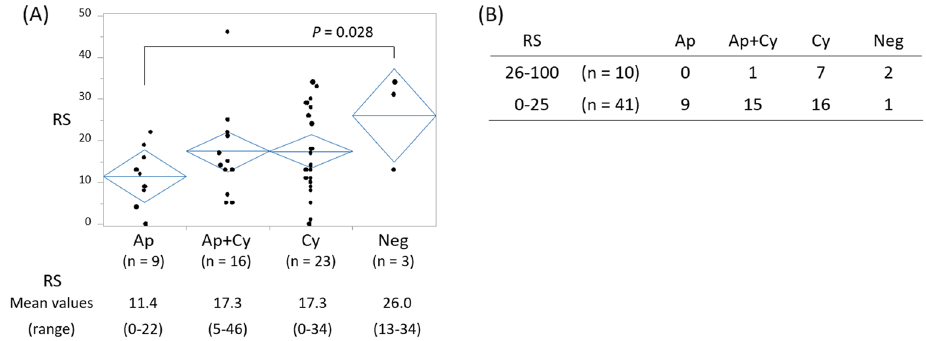
Figure 2. MUC1 staining patterns and recurrence score. ( A ) Recurrence score (RS) according to the MUC1 staining pattern. Horizontal blue lines indicate the mean values of each group. ( B ) RS distribution according to MUC1 staining when patients were divided into two groups, high and low RS. Ap apical, Ap + Cy apical + cytoplasmic, Cy cytoplasmic, Neg